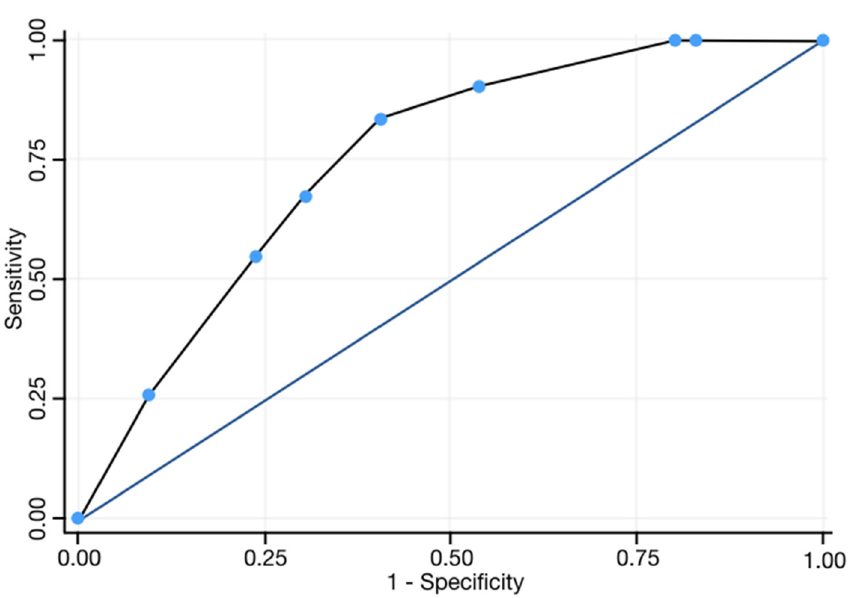
Figure 1. Receiver operating characteristic analysis of the experimental model for poor response or resistance to first line anti-myeloma treatment. The prediction model includes Procoag-PPL ® clotting time, D-Dimer, and thrombin Peak and has 84% sensitivity, 60% specificity. Area under the curve = 0.75.